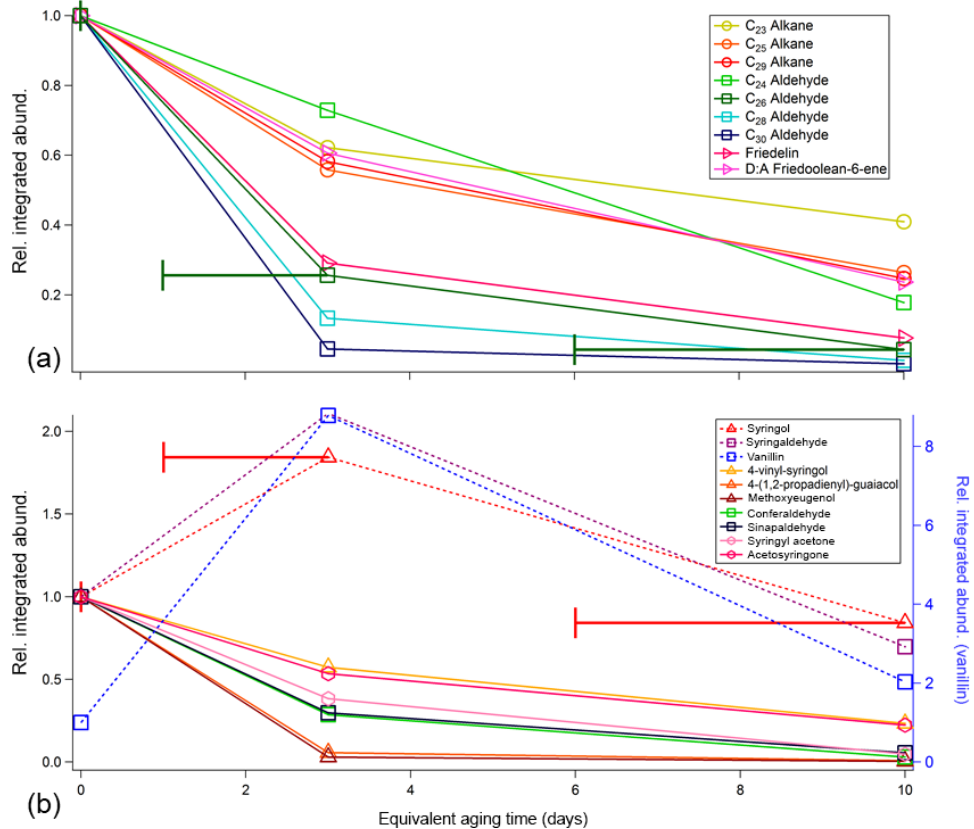
Figure 3. Relative changes in integrated abundance as a function of equivalent aging time (per SO 2 calibrations) for primary compounds iden- tified in (a) oak leaf BBOA chromatograms and (b) oak heartwood BBOA chromatograms. For each compound, the integrated abundances were first normalized to appropriate volume concentrations, then subsequently normalized to corresponding abundances at no oxidation (“0 days”). Compounds that decrease in abundance are indicated with solid lines, and compounds that deviate from this trend are given with dotted lines. Raw compound abundances are provided in the Supplement (Table S6). The x -axis error bars denote equivalent aging time ranges calculated for this study and are applicable to all TAG data presented here, though they are only included on one compound per panel to preserve figure